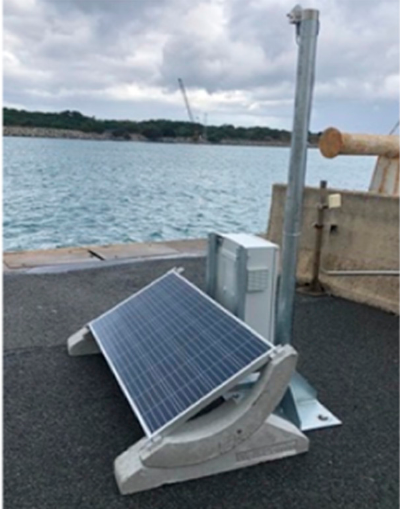
Figure 13. Ground motion and structural monitoring at the port of the Gioia Tauro within the TURNkey project.